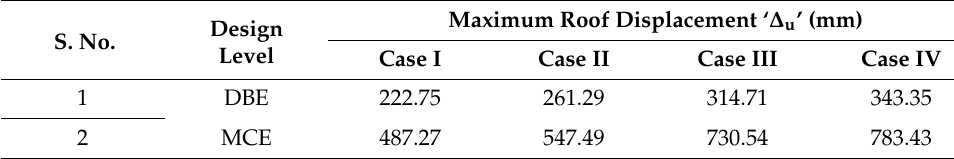
Table 4. Maximum roof displacement under unidirectional loading.